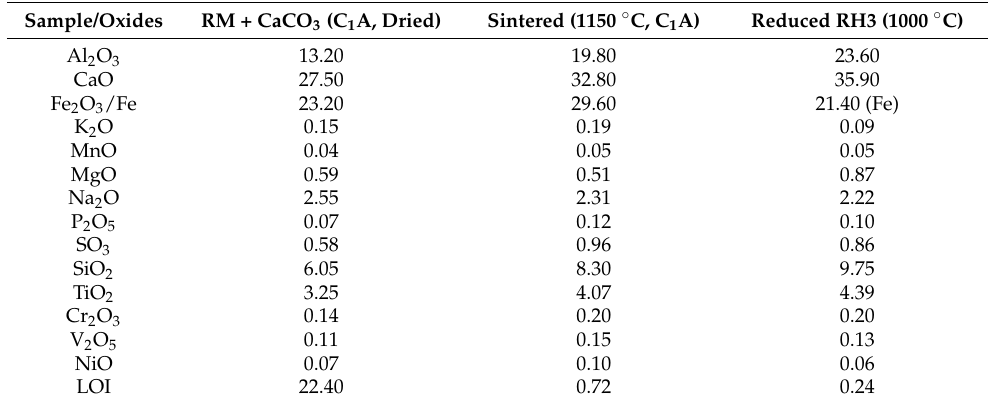
Table 1. XRF analysis of dried, sintered and reduced pellets.